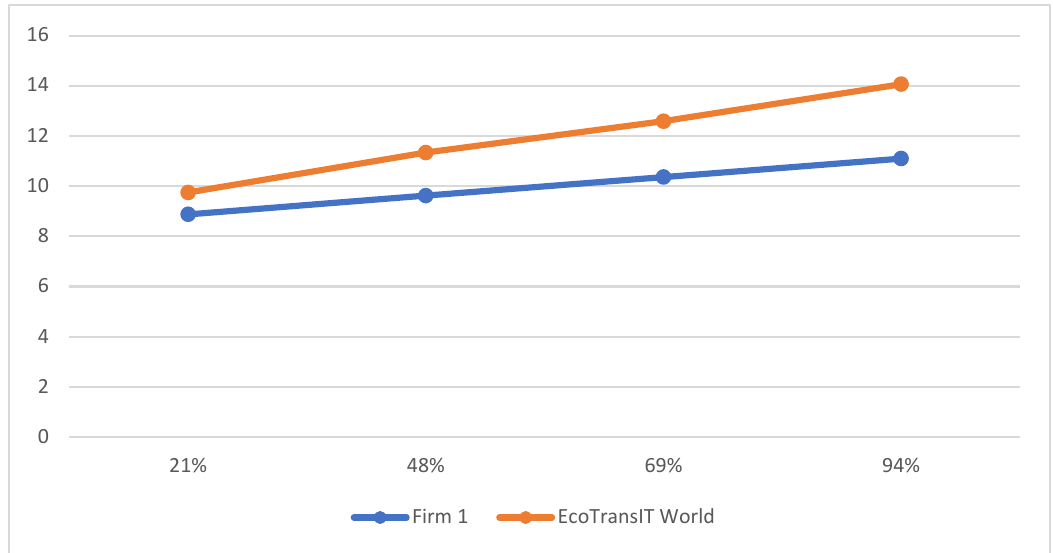
Figure 2. Energy consumption in HDV depending on the load capacity.